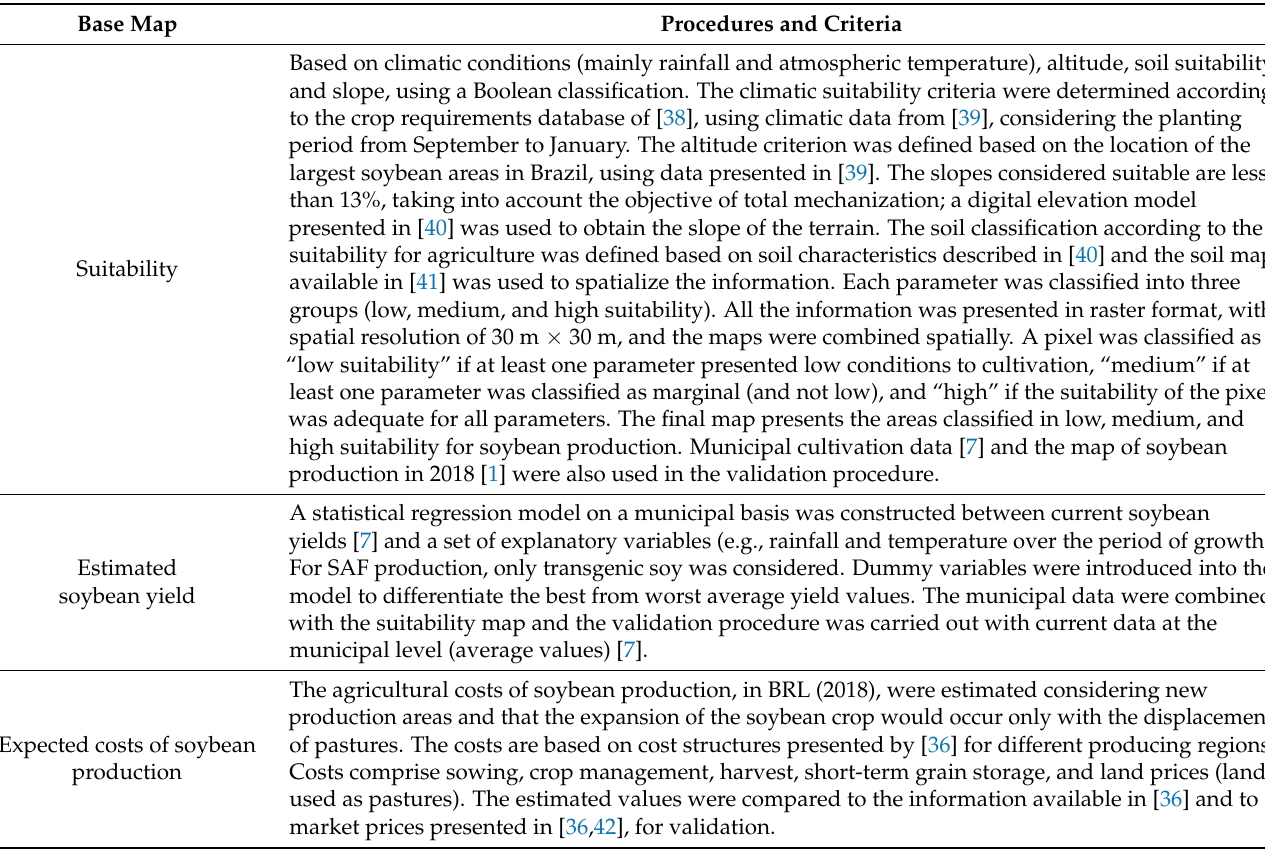
Table 1. General procedures and main assumptions considered in the development of maps of suitability, yields, and costs of soybean